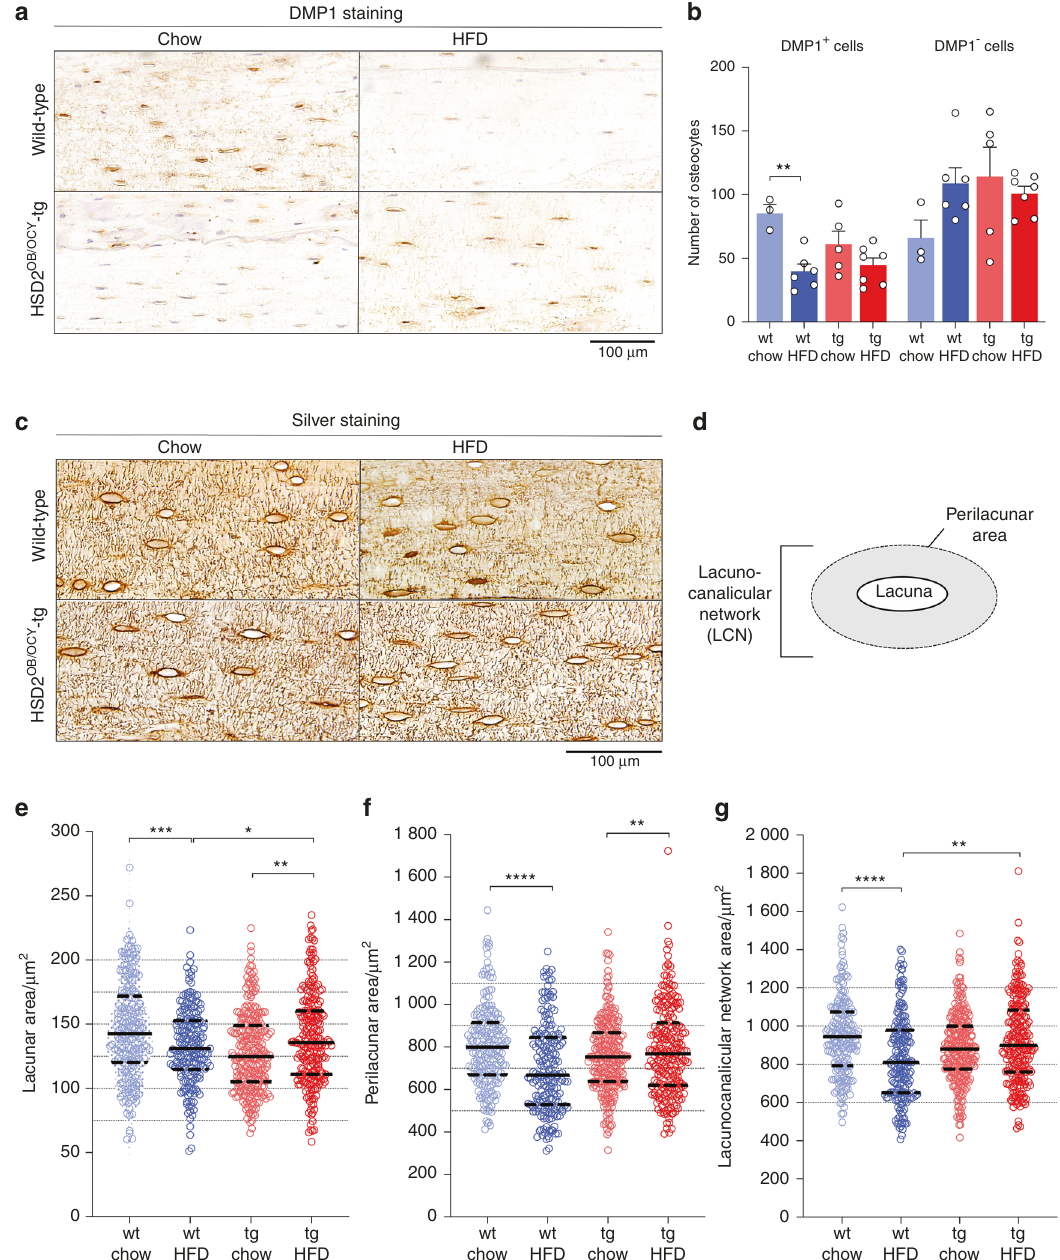
Fig. 5 HFD feeding disrupted the lacunocanalicular network (LCN) in wild-type mice but not in HSD2 OB/OCY -tg mice. a Representative images of DMP1-stained tibial sections from wild-type and HSD2 OB/OCY -tg mice fed either chow or HFD for 18 weeks. b Number of DMP1-positive and DMP1-negative osteocytes in sections from wild-type and HSD2 OB/OCY -tg mice. The results are shown as scatterplots, with the mean ± SEM shown in columns. Signi fi cance was determined using two-way ANOVA for DMP1 + and DMP1 − cells, with the Tukey ’ s multiple comparison test used for post hoc testing. c Representative images of silver nitrate-stained tibial sections from wild-type and HSD2 OB/OCY -tg mice fed either chow or HFD for 18 weeks. d Diagram for determination of the lacunar area, perilacunar area, and the entire LCN. e Distribution of the lacunar area; median and quartlies (1st and 3rd) are shown by solid and dashed lines, respectively. Dotted lines show bin sizes used for the χ 2 -test, which was used to compare distributions. Signi fi cance was adjusted for multiple comparisons using Bonferroni ’ s method. f Distribution of the perilacunar area. g Distribution of the entire LCN area. In all cases, * P < 0.05, ** P < 0.01, *** P < 0.001, and **** P < 0.000 1 for triglycerides (Fig. 7j). Fasting NEFA concentrations were not phase, Fig. 7h), while it remained unchanged in wild-type mice. affected by diet or genotype (Fig. 7k). Therefore, disrupting Taken together, these results indicated that selectively disrupting skeletal glucocorticoid signaling not only prevented HFD-induced glucocorticoid signaling in osteoblasts and osteocytes prevented bone loss but also markedly attenuated the development of HFD- HFD-induced central obesity by increasing energy expenditure. induced obesity and its metabolic complications, including insulin In wild-type mice but not HSD2 OB/OCY -tg mice, HFD feeding also resistance, glucose intolerance, and dyslipidemia. increased fasting concentrations of total cholesterol (Fig. 7i) and